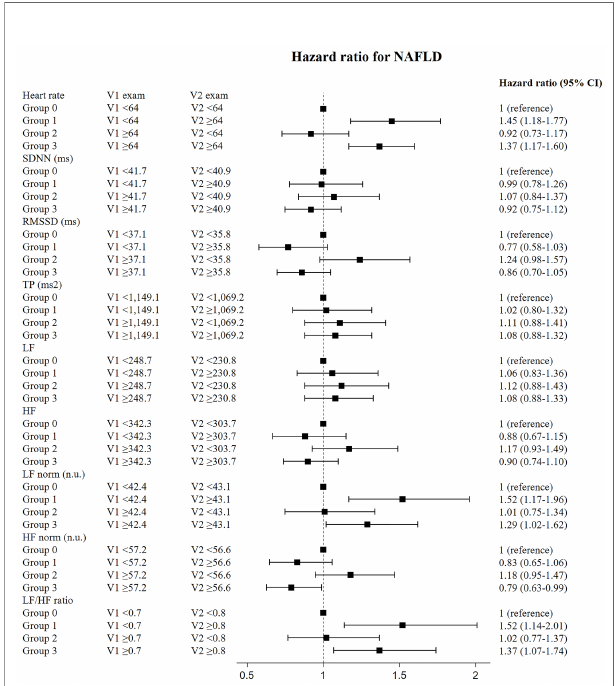
FIGURE 3 | Risk of incident diabetes according to change of HRV measurement in the participants who underwent follow-up HRV exam within two years. Data shown in this fi gure is included in supplemental materials ( Supplementary Table 5